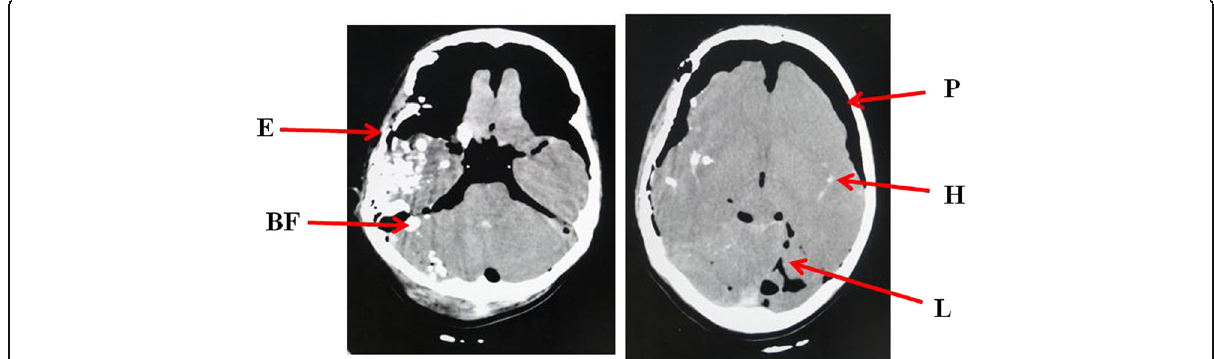
Fig. 3 Gunshot injuries of the head. PMCT axial image showing the exit wound (E) in the vault of the skull with comminuted fractures in the skull bones on the opposite side (right frontal) and intracerebral detached bony fragments (BF). Axial image showing lacerations of the brain (L), pneumocephaly (P), and massive intracerebral hemorrhage (H)